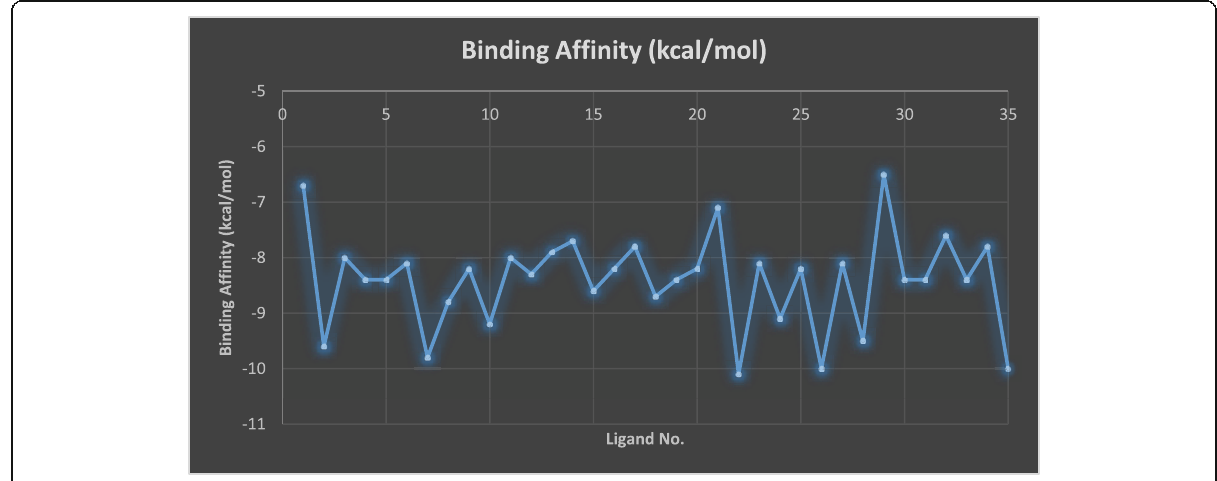
Fig. 5 Binding affinity scores of the IPAs (ligands) with the modeled QcrB